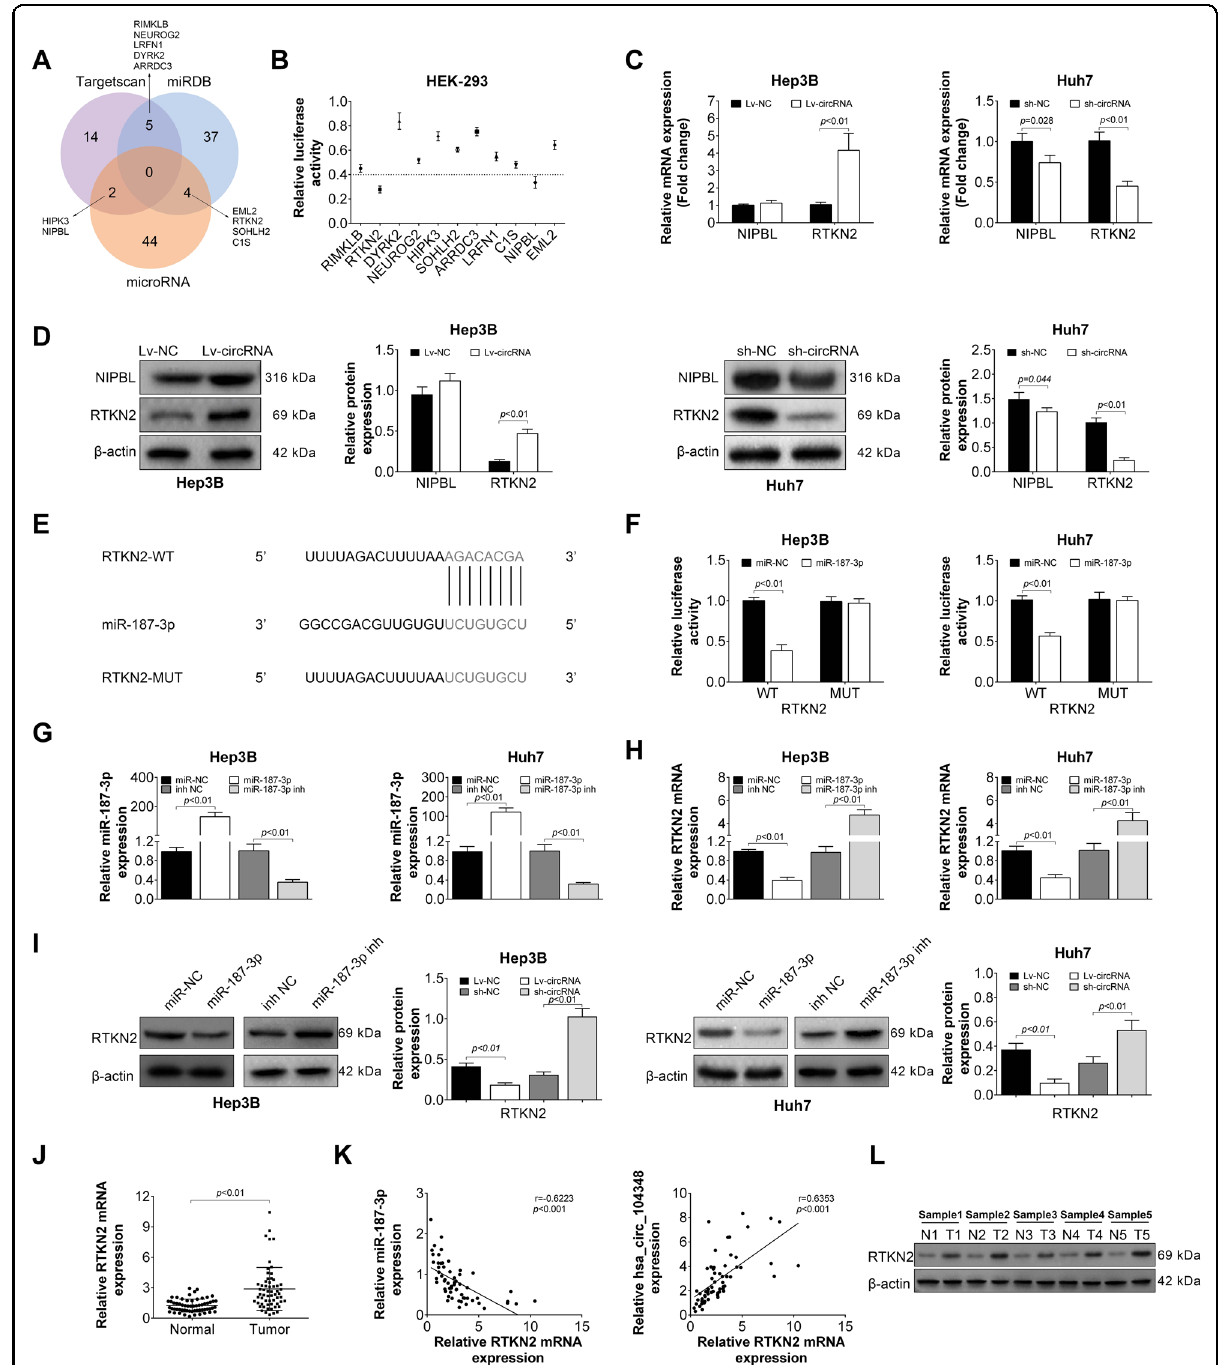
Fig. 5 RTKN2 was a direct target of miR-187-3p. A The potential target of miR-187-3p was predicted by Targetscan, miRDB, and microRNA. B Relative luciferase activity of 11 genes was detected by dual-luciferase reporter assay. C and D The mRNA and protein level of RTKN2 and NIPBL in has_circ_104348 overexpression or knockdown systems was determined by qRT-PCR ( C ) or western blot ( D ). E RTKN2 3 ′ -UTR wide-type and the mutated-type in the miR- 187-3p-binding sites were shown. F Luciferase activity of HEK293 cells co-transfected with miR-187-3p mimics or NC mimics and luciferase reporters containing RTKN2 3 ′ -UTR WT or RTKN2 3 ′ -UTR MUT transcript were determined by dual-luciferase reporter assays. G The transfection ef fi ciency of miR-187- 3p mimics and inhibitors was tested. H and I The levels of RTKN2 transfected with miR-187-3p mimics or NC mimics, as well as miR-187-3p inhibitor or NC inhibitor in HCC cells were analyzed by qRT-PCR ( H ) and western blot ( I ). J The expression of RTKN2 and corresponding normal tissues were detected by qRT-PCR. K The correlation between RTKN2 and miR-187-3p, as well as RTKN2 and has_circ_104348 expression was analyzed. L he protein level of RTKN2 in HCC patients and normal subjects were measured in fi ve samples by western blot. Data were expressed as